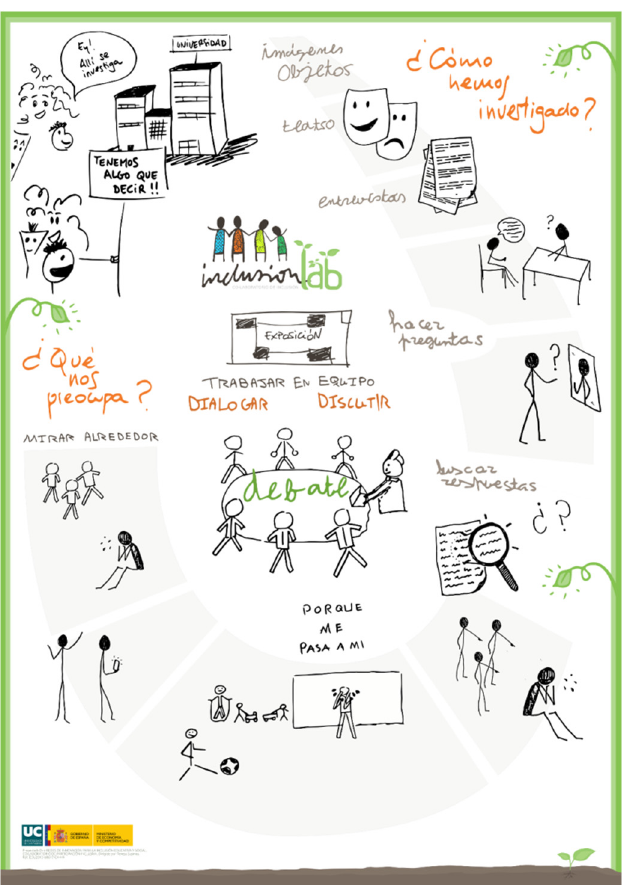
Figure 4. Poster of the research process used in the exhibition. (From left to right and from top to bottom: We have something to say/How did we conduct our research? Images, objects, theater, asking questions, looking for answers. Which concerns us? Looking around us. Working as a team: dialogue and discussion).